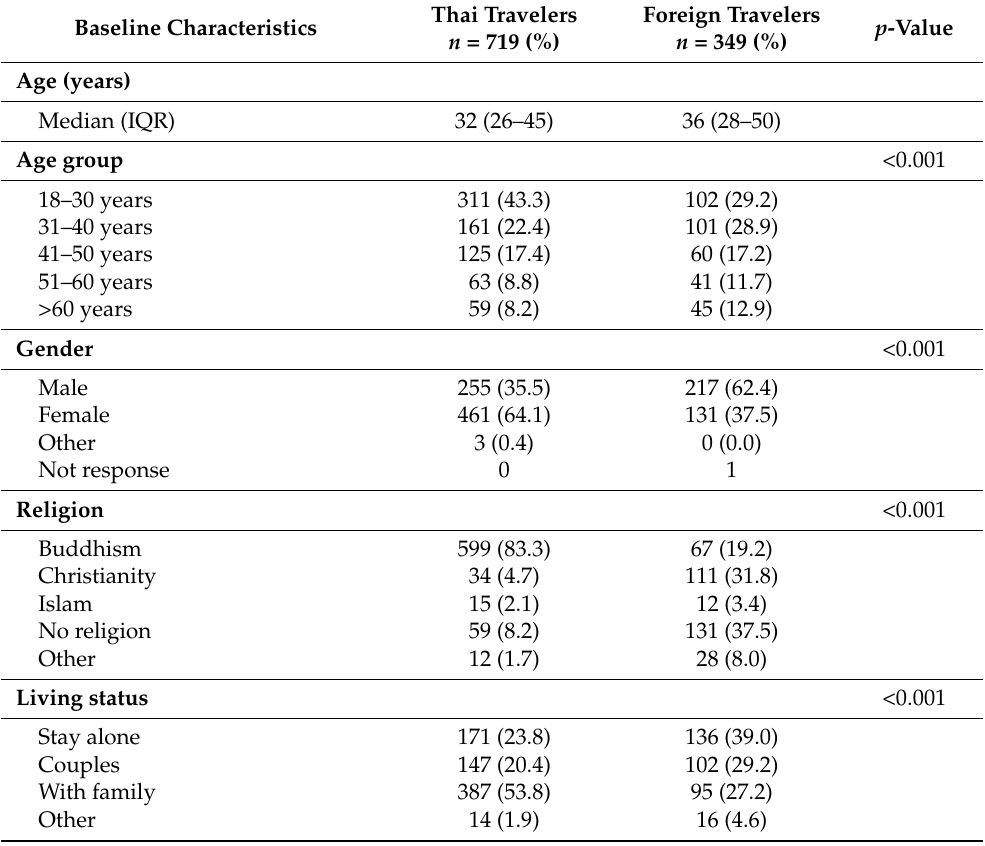
Table 1. Baseline characteristics of this